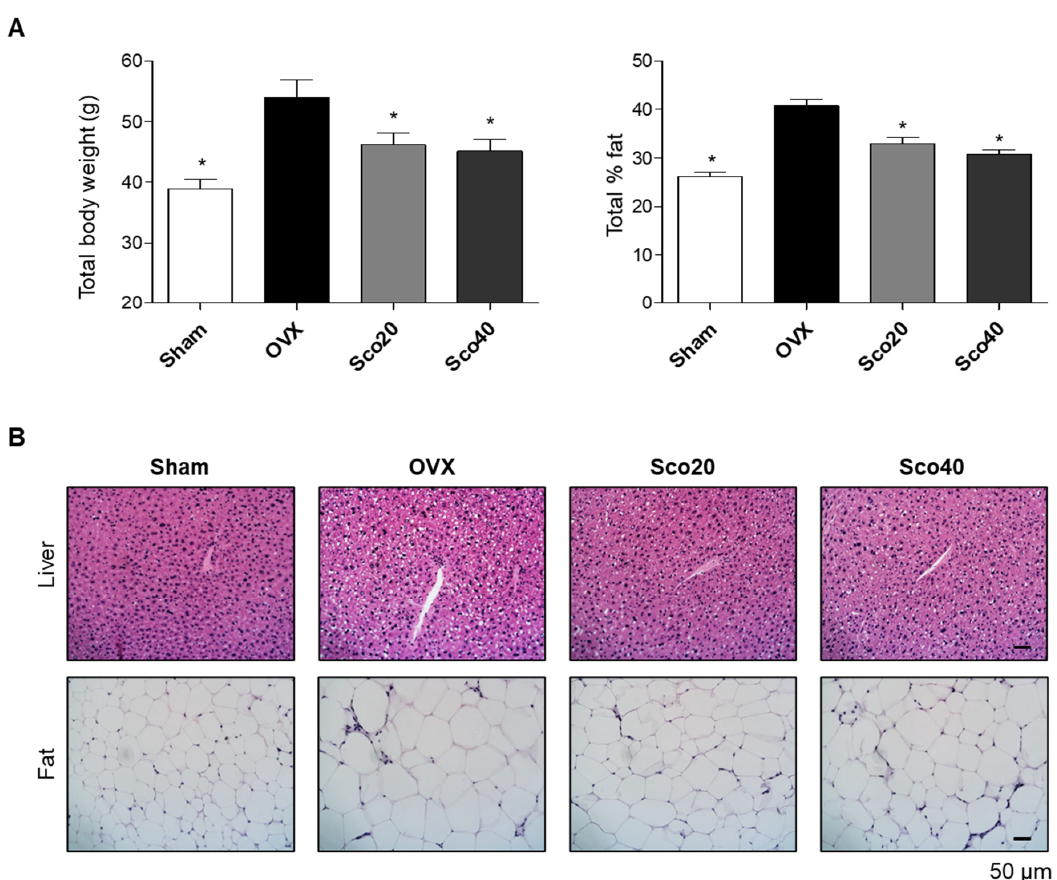
Figure 3. Scopolin inhibited an OVX-induced increase in body weight, hepatic steatosis, and the